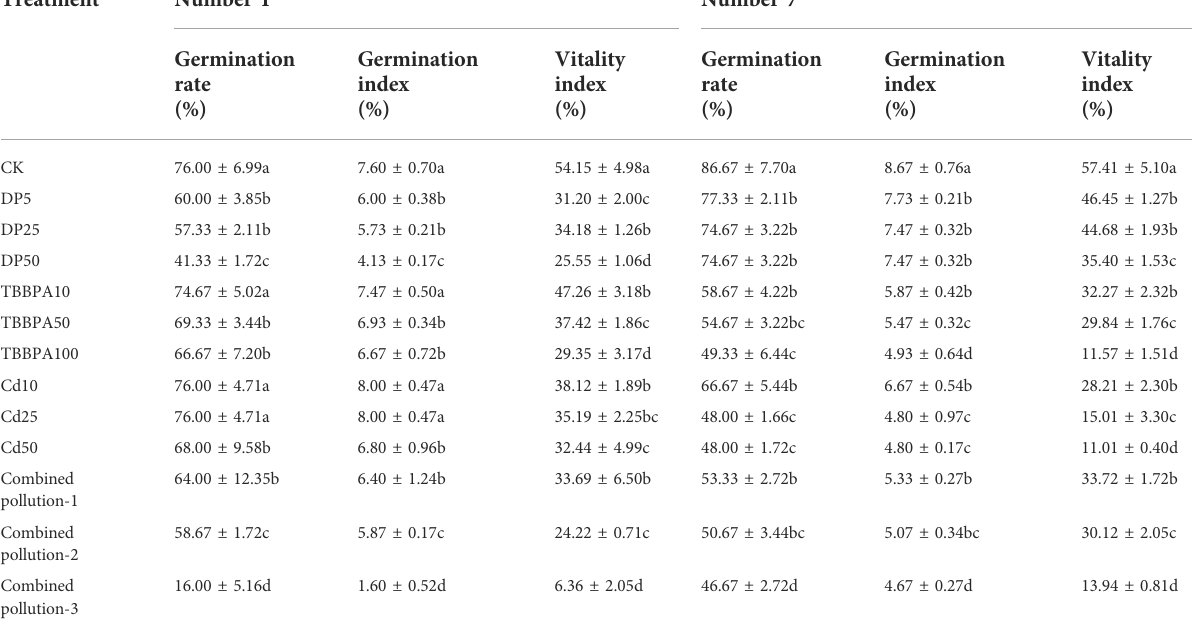
TABLE 1 Effects of halogenated fl ame retardants and Cd on germination of two types of rice seed.